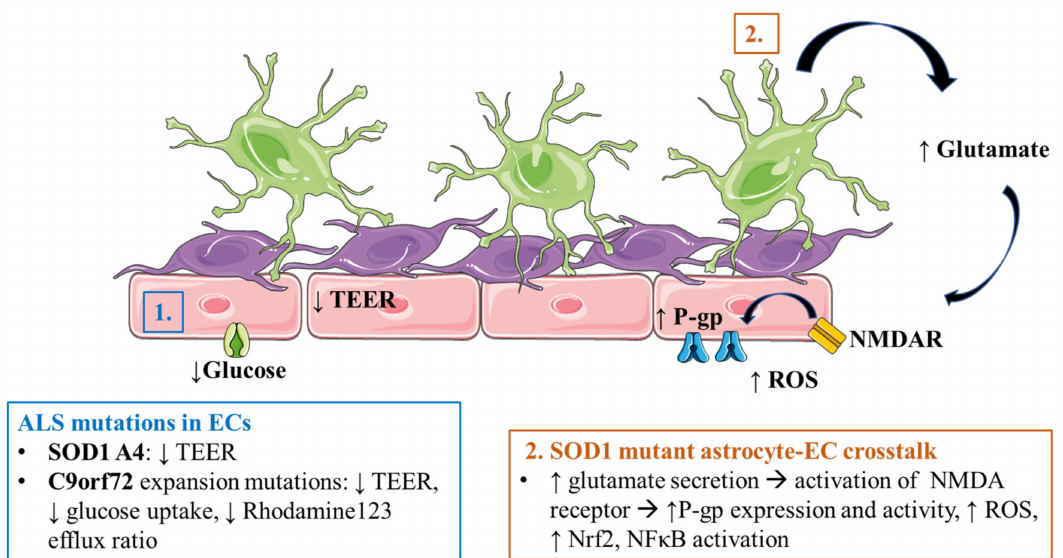
Figure 3. Schematic illustration of BBB dysfunction in ALS based on iPSC-BBB